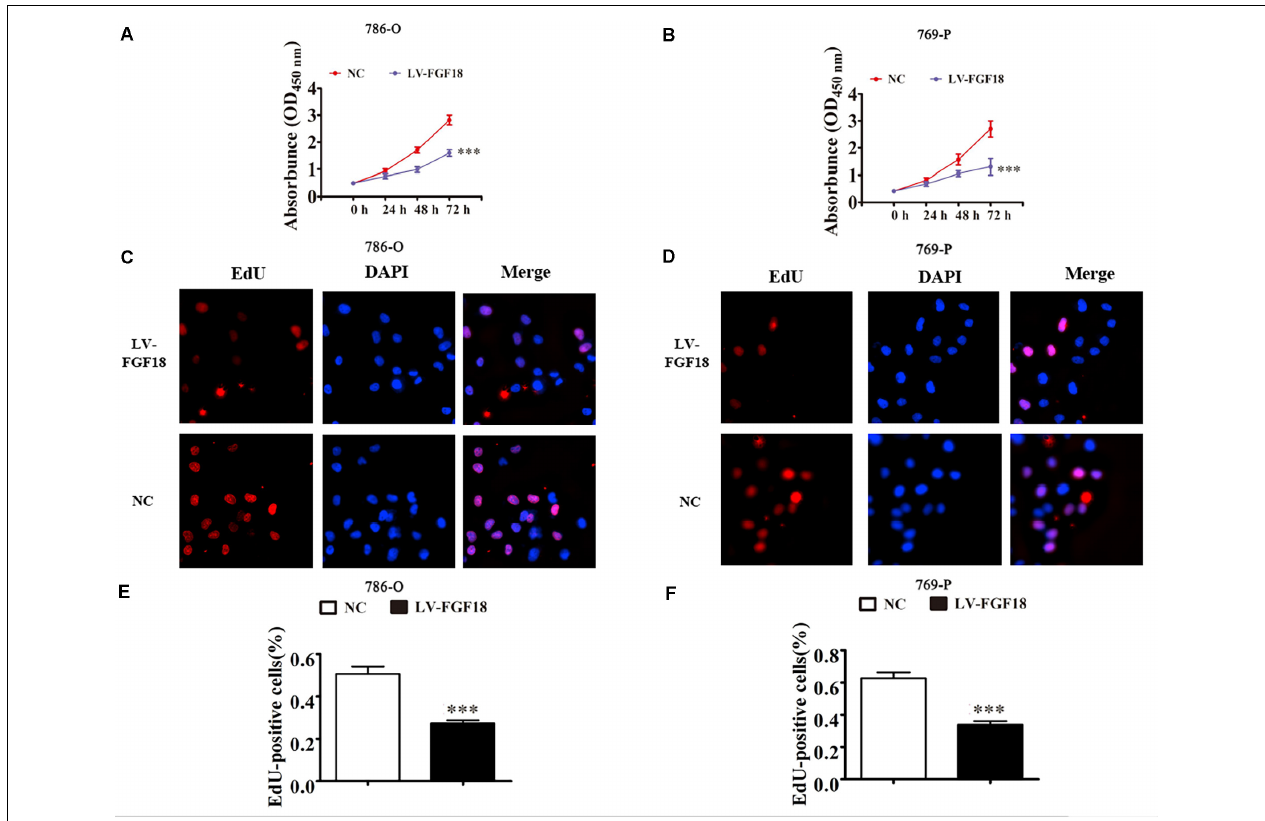
FIGURE 4 | FGF18 overexpression suppresses cellular proliferation in ccRCC cells. (A,B) CCK8 assay showed that FGF18 overexpression reduced the proliferation of both 786-O and 769-P cells. Data of three experiments are presented as the mean ± SD. ∗∗∗ p < 0.001 versus NC. (C,D) EdU assay compared proliferation ability between FGF18 over-expression and NC group in both 786-O and 769-P cells. (E,F) The relative percentage of EdU positive cells was calculated for both 786-O and 769-P cells in three experiments. Data of three experiments are presented as the mean ± SD, ∗∗∗ p < 0.001 versus NC.